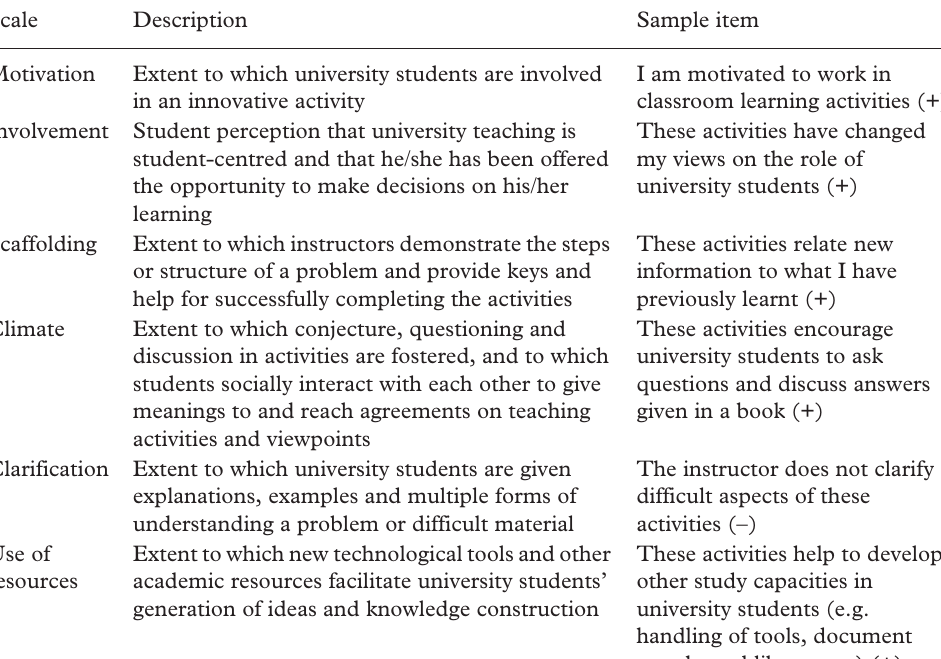
Table 2. Description of scales and a sample item for each scale of the AUTAQ